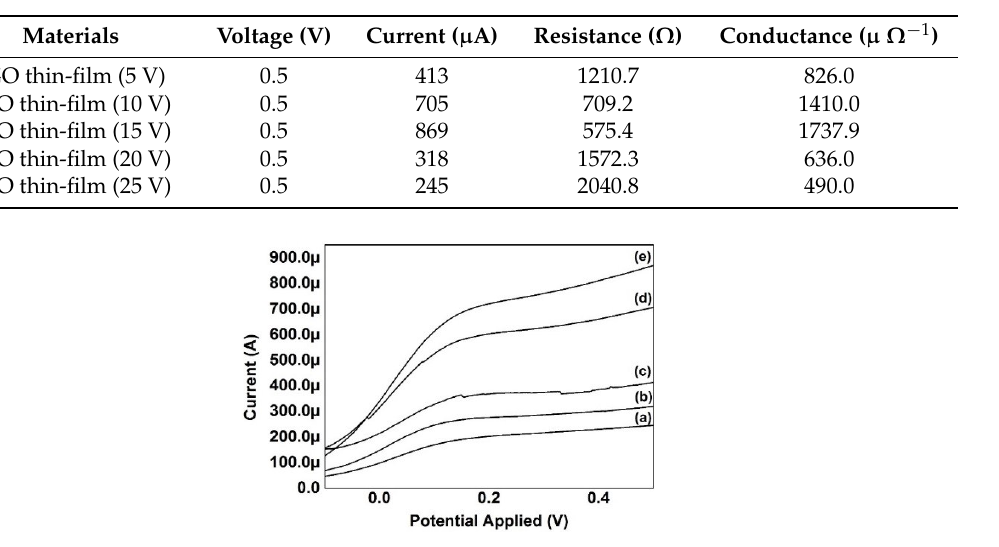
Table 3. Resistance and conductance values of rGO thin-films prepared at 5, 10, 15, 20, and 25 V by electrochemical reduction for 5 min calculated at voltage, V = 0.5 V.